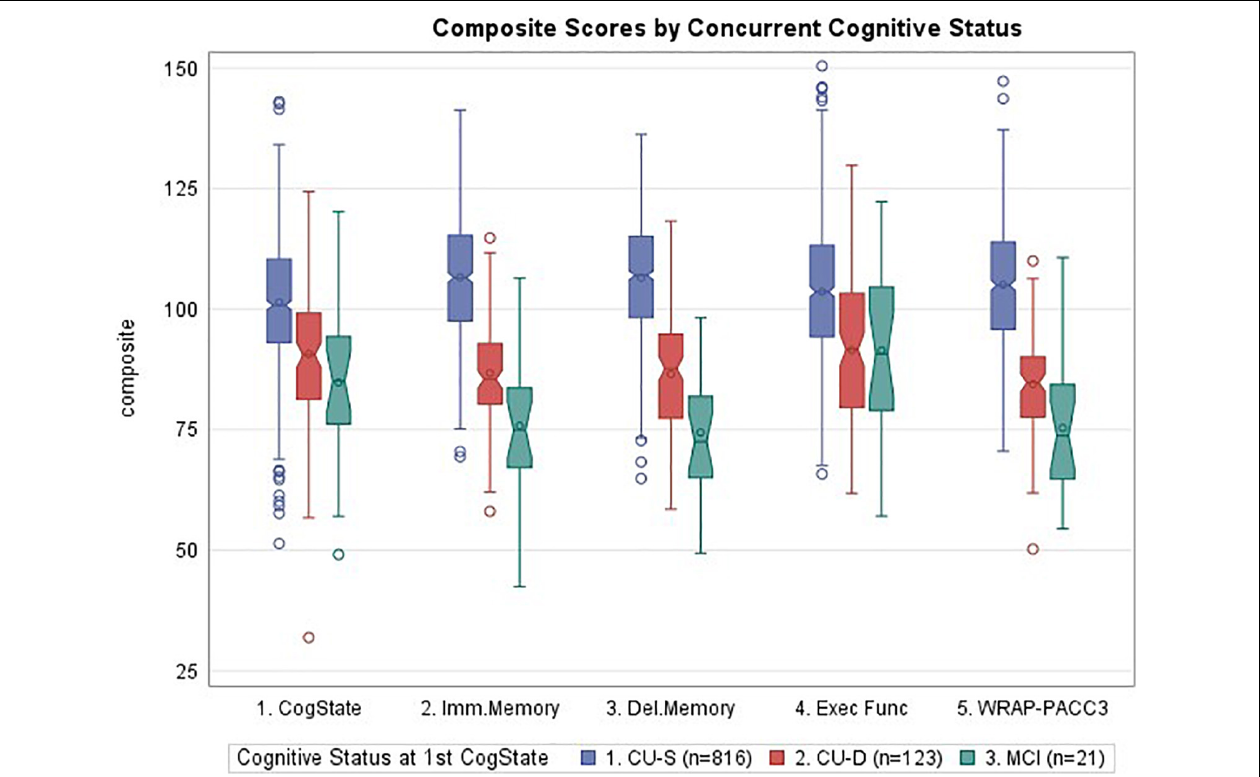
FIGURE 2 | Notched boxplots of cognitive composites by concurrent cognitive status, where notches represent the median ± 1.58*(interquartile range/square root of n ). CogState, CogState composite; Imm.Memory, immediate memory composite; Del.Memory, delayed memory composite; Exec Func, executive function composite; WRAP-PACC3, WRAP’s version of the preclinical Alzheimer’s cognitive composite (see Table 1 for tests contributing to each composite). Values represent demographically adjusted standard scores [mean (SD) = 100 (15)]. P < 0.0001 for all five composites; pairwise differences and effect sizes indicated in Table 3.